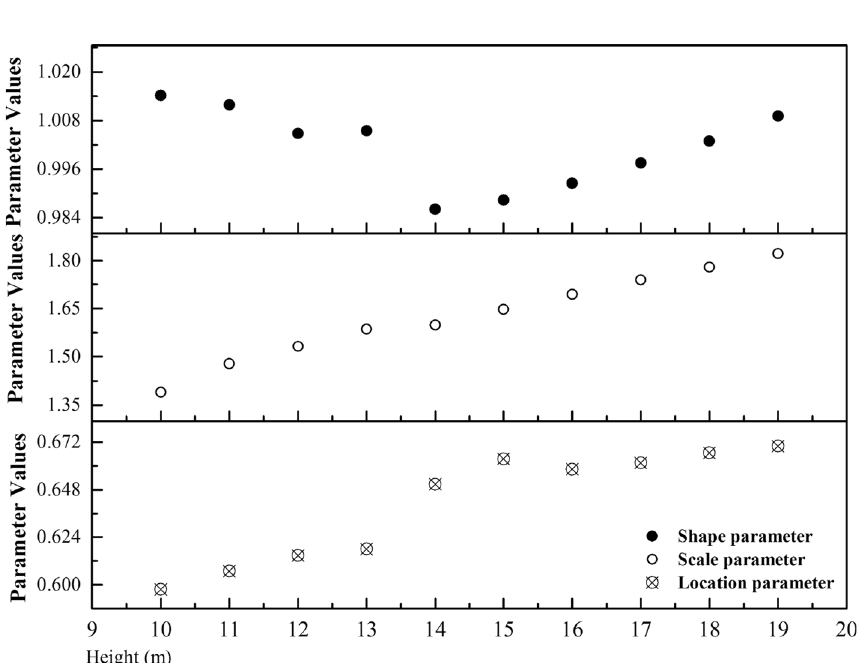
Figure 11. Parameter values of Weibull distribution function at each observed